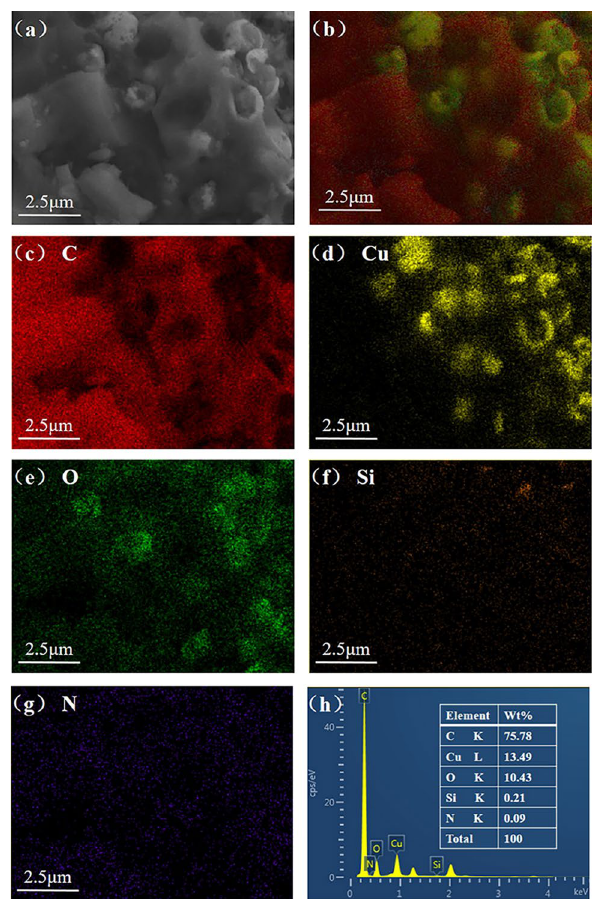
Figure 3. SEM image of CMS-WBB ( a ), EDS layered image of CMS-WBB ( b ), element mapping of C ( c ), Cu ( d ), O ( e ), Si ( f ) and N ( g ) on CMS-WBB, EDS spectra of CMS-WBB ( h